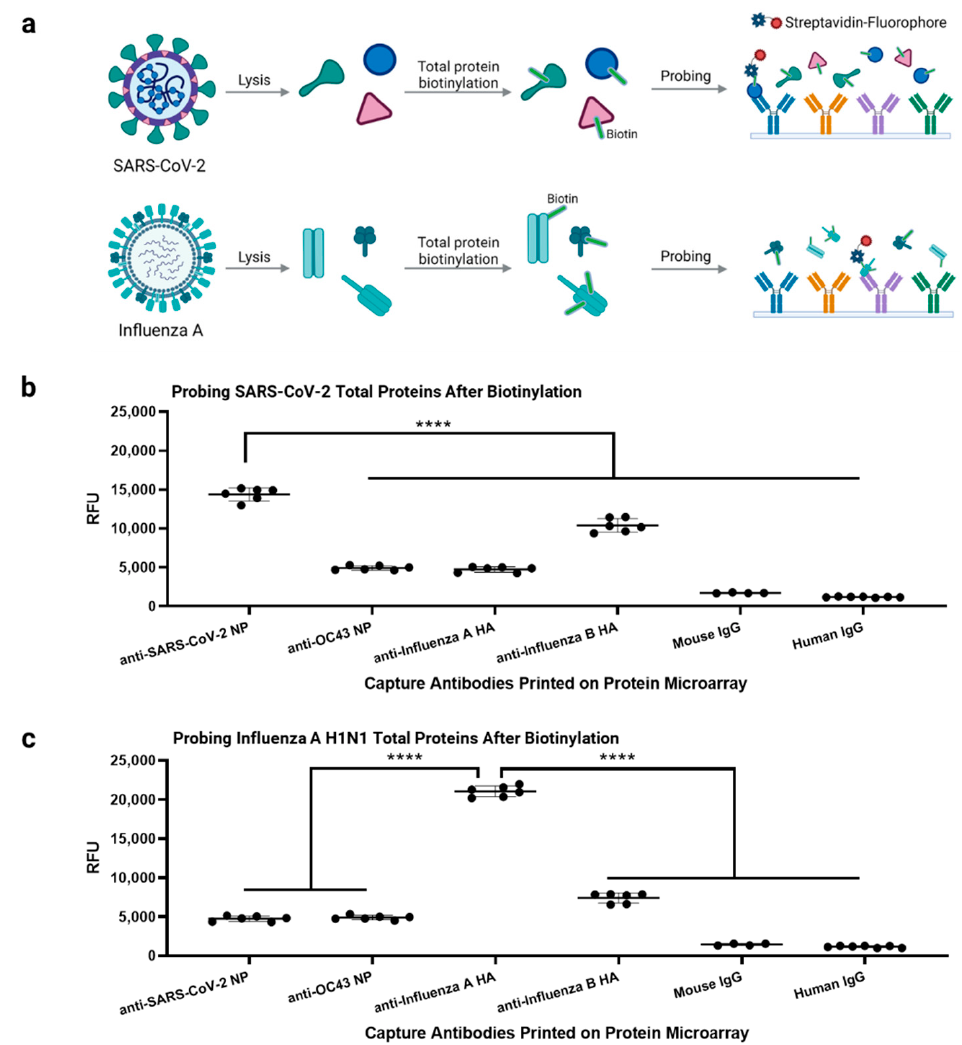
Figure 6. Multiplex detection of viral antigens from inactivated SARS-CoV-2 and influenza A virus after total protein biotinylation. ( a ) To detect the target antigens (SARS-CoV-2 NP and Influenza A HA), inactivated viruses were lysed, and total proteins were biotinylated for probing. This panel was created with BioRender.com. ( b ) Detection of inactivated SARS-CoV-2 sample using the protein microarray is shown. ( c ) Detection of inactivated influenza A H1N1 sample using the protein microarray is shown. The anti-Influenza B HA antibody resulted in the highest non-specific signals. One-way ANOVA, followed by Tukey’s multiple comparison test, was performed for statistical analysis. A single experiment with six technical replicates were tested for each antibody, except the mouse IgG (four technical replicates). **** p <